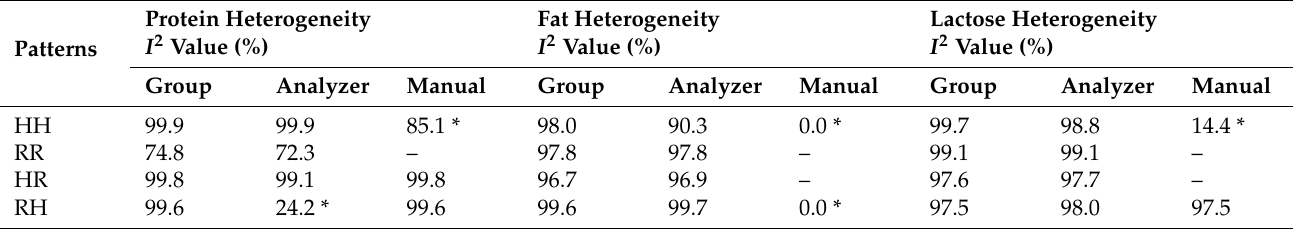
Table 4. Values of subgroup with the analytical method.